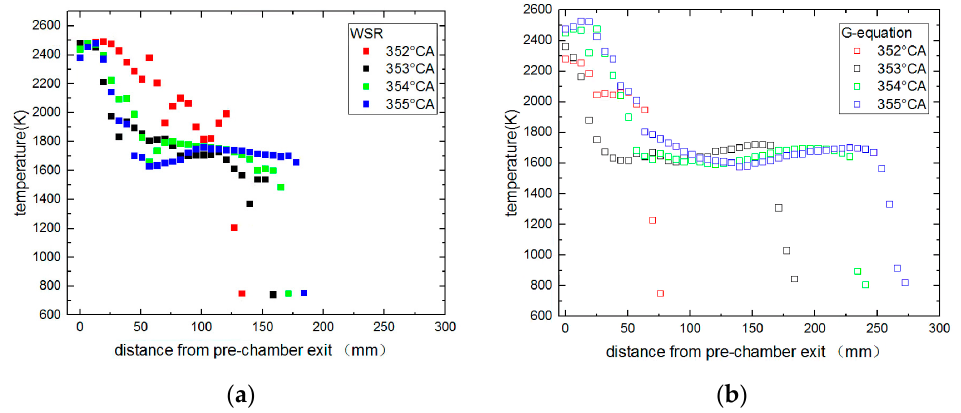
Figure 8. Local temperature results and the corresponding distance from pre-chamber exit at different times, using ( a ) the WSR model and ( b ) the G-equation model.